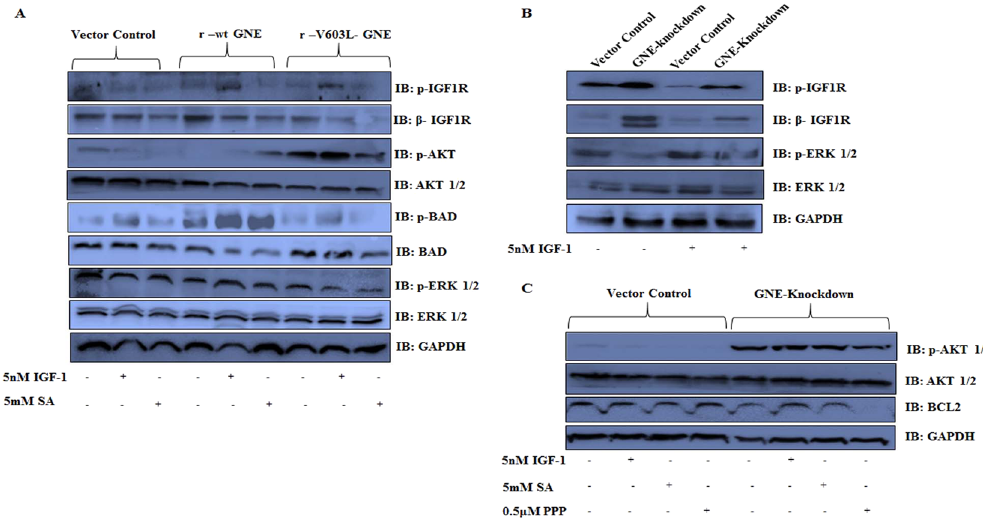
Figure 4. Effect of GNE deficiency on IGF-1R downstream signaling pathway: Cells were grown in DCCM, followed by treatment with 5 nM IGF-1 for 10 min or treatment with 5 mM Sialic Acid or 0.5 μ M PPP (IGF-1R inhibitor) for 24 h. ( A ) GNE mutant cells along with r-wt GNE and vector control cell lysates after treatment with or without 5 nM IGF-1 or 5 mM SA were separated on SDS–PAGE and immunoblotted with p-IGF-1R/ β - IGF-1R, p-AKT/AKT, BAD/p-BAD, p-ERK/ERK1/2 and GAPDH antibodies. ( B ) GNE knockdown and vector control cell lysates with or without 5 nM IGF-1 treatment were separated on SDS–PAGE and immunoblotted with p-IGF-1R/ β -IGF-1R, p- p-ERK/ERK1/2 and GAPDH antibodies. ( C ) GNE knockdown and vector control cell lysates after treatment with or without 5 nM IGF-1, 5 mM SA or 0.5 μ M PPP (IGF-1R inhibitor) were separated on SDS–PAGE and immunoblotted with p-AKT/AKT, BCL2 and GAPDH